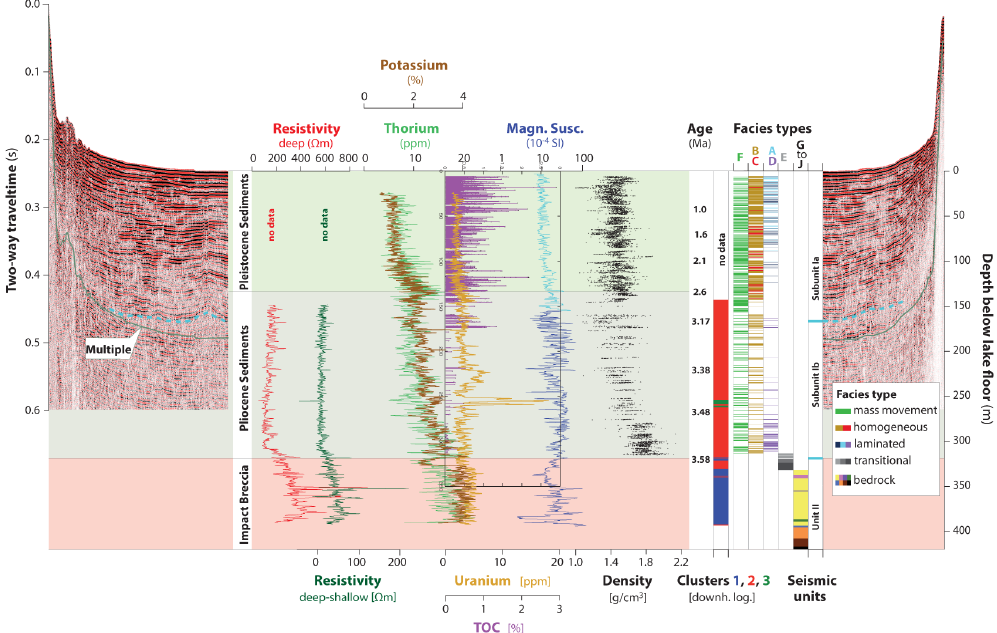
Fig. 3. Single-channel seismic reflection profile AWI-20008130 (acquired with a Bolt 600B airgun) with inset of downhole logging and core physical properties data. Note that the light-blue part of the magnetic susceptibility data derive from direct core measurements, while the dark blue part is from downhole logging measurements – i.e. exact values and amplitudes of the two datasets are not directly comparable. Dashed turquoise horizontal lines mark the boundaries of seismic subunits 1a and 1b; the boundary between units I and II is taken from Gebhardt et al. (2006). Sedimentary facies comprise mass movement deposits (facies F; green), massive interglacial sediments (facies B; ochre), laminated super interglacial sediments (facies C; red), laminated Quaternary glacial sediments representing “cold & dry” (facies A d ; light blue) and “cold & moist” climates (facies A m ; dark blue), laminated Pliocene sediments (facies D; lilac), and transitional sediments between impact breccia and lake sediments (facies E; gray). Facies types are used sensu Melles et al. (2007, 2012) and Brigham-Grette (2013). The impact breccia/suevite succession according to Koeberl et al. (2012) is given as follows: yellow: suevite; lilac: upper volcanic rock layer; violet: lower volcanic rock layer; green: ignimbrite. The clusters derived from k-mean clustering of downhole logging data are shown in blue for cluster 1, red for cluster 2 and green for cluster 3. Ages are taken from Nowaczyk et al.